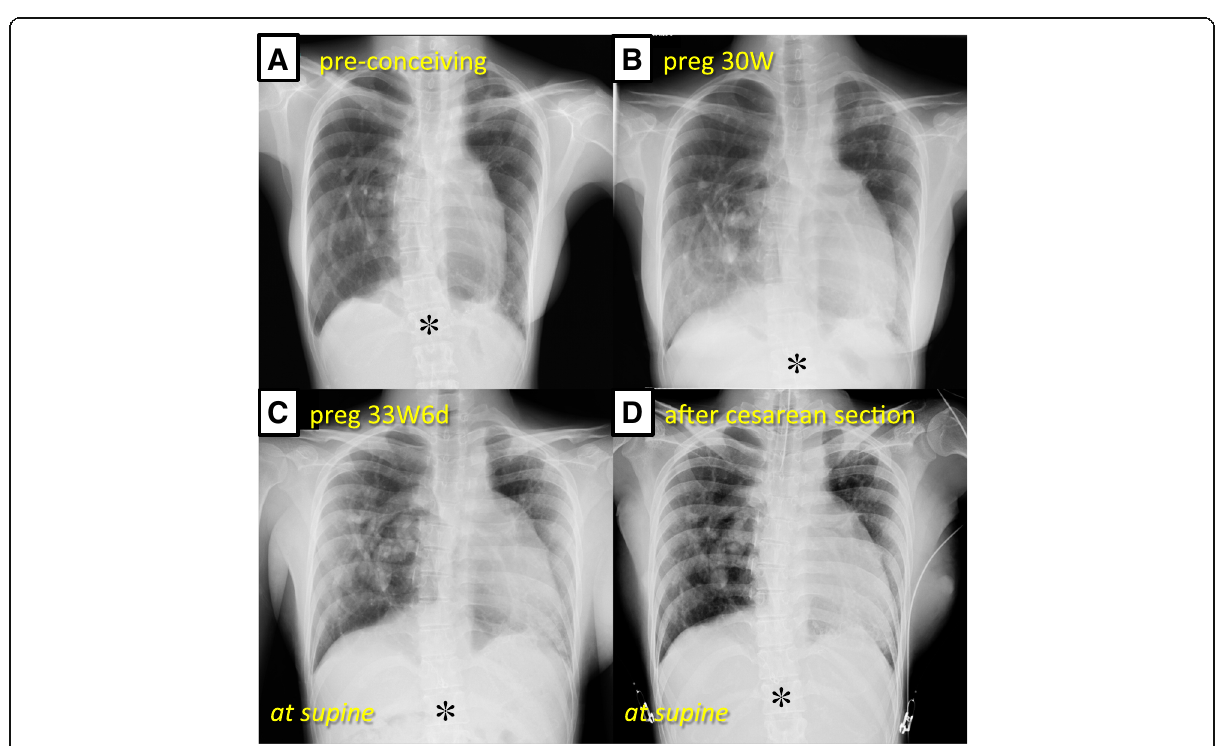
Fig. 2 a Chest X-ray, at pre-conception, demonstrated that the right lung looked over-infiltrated and was bulging into the left thorax. b At 30 weeks of gestation, the position of the diaphragm was located at the same level as before conception, while vascular shadows in the right lung field were increased. (Asterisk marks the 12th thoracic vertebra in each chest X-ray.) c On the day before cesarean section, chest X-ray in supine position confirmed no significant displacement of the diaphragm, when considering the impact of the posture on diaphragm position; however, it revealed further increase of vascular shadows in the right lung field. d No abnormal findings in the lung field and no significant change of the diaphragm level, compared with those the day before the operation, were confirmed, immediately after the cesarean